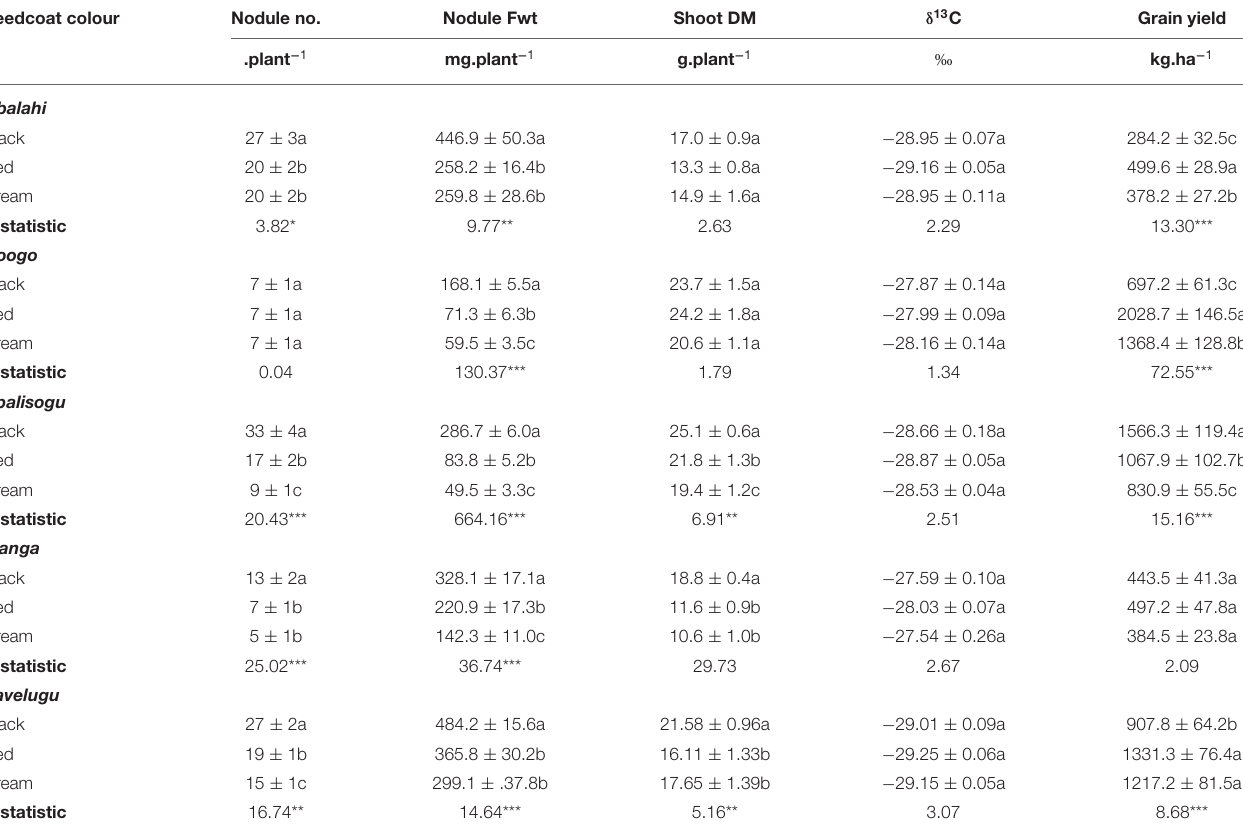
TABLE 4 | Nodulation, shoot dry matter (DM), δ 13 C values and grain yield of Bambara groundnut landraces with different seedcoat colours sampled from five sites in Ghana. Seedcoat